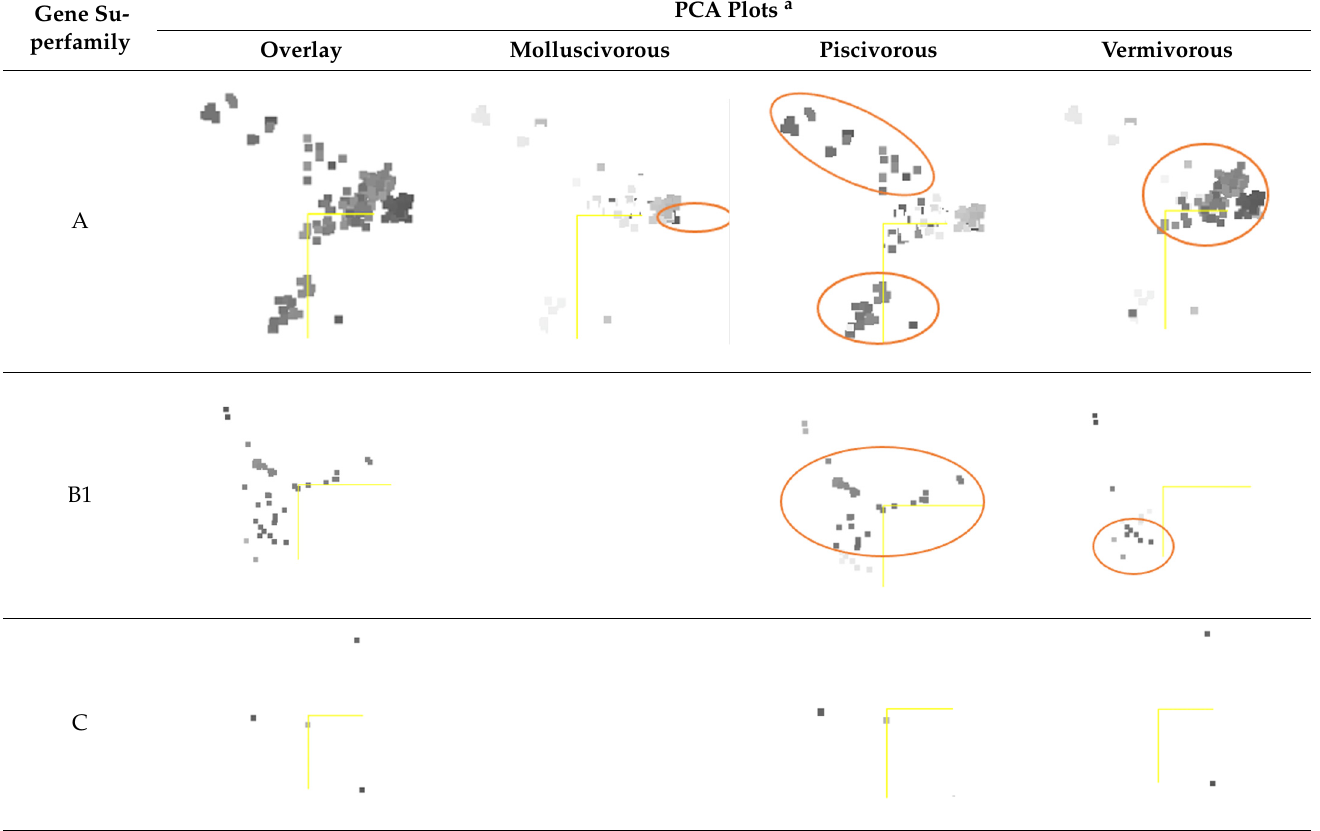
Table 2. Principal component analysis plots.